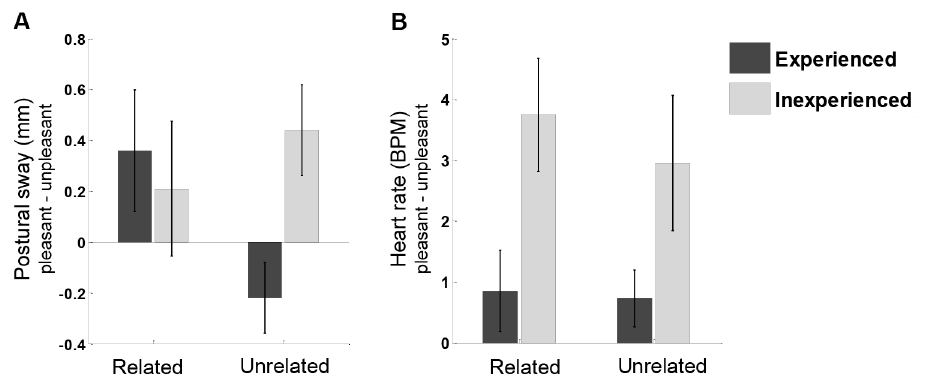
Fig 1. Freezing (pleasant versus related- and unrelated-unpleasant pictures) in terms of postural sway and heart rate for experienced and inexperienced firefighters. Positive bars reflect reducedsway or heart rate for (un)related-unpleasantpictures relative to pleasant pictures. (A) Inexperienced versus experienced firefighters show reducedpostural sway (mm SD-AP) as inducedby unrelated-unpleasant pictures. (B) Inexperienced versus experiencedfirefighters show reducedheart rate (BPM) as inducedby related-unpleasant pictures. Error bars represent standard error of the mean.